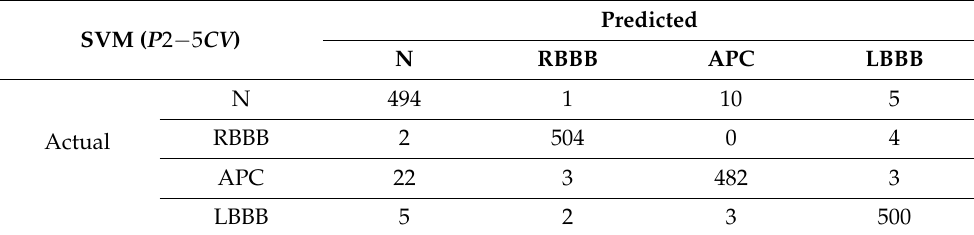
Table 6. Confusion matrix for the SVM classifier applied to the P 2 dataset withinthe 5CV protocol (Accuracy =